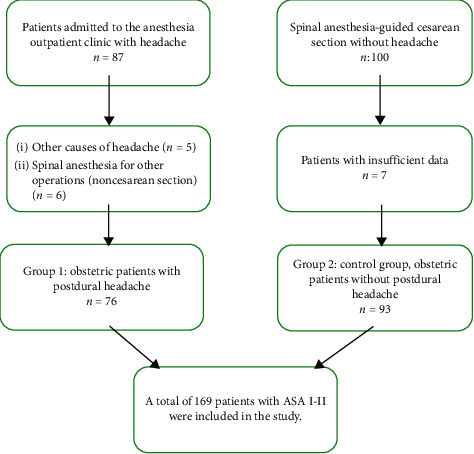
Study flow diagram.